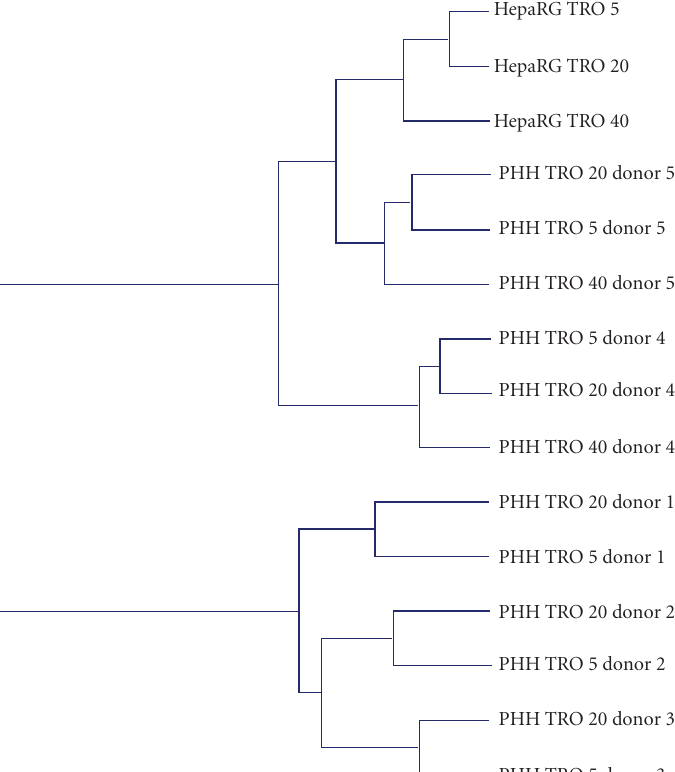
Figure 1: Two-dimensional hierarchical clustering of gene expression profiles induced by TRO treatment in primary human hepatocytes from five donors and HepaRG cells. The clustering was generated by using the Resolver system software with an agglomerative algorithm, the Ward’s min variance link heuristic criteria, and the Euclidean distance metric. Cultures and microarray analysis as in Table 2.